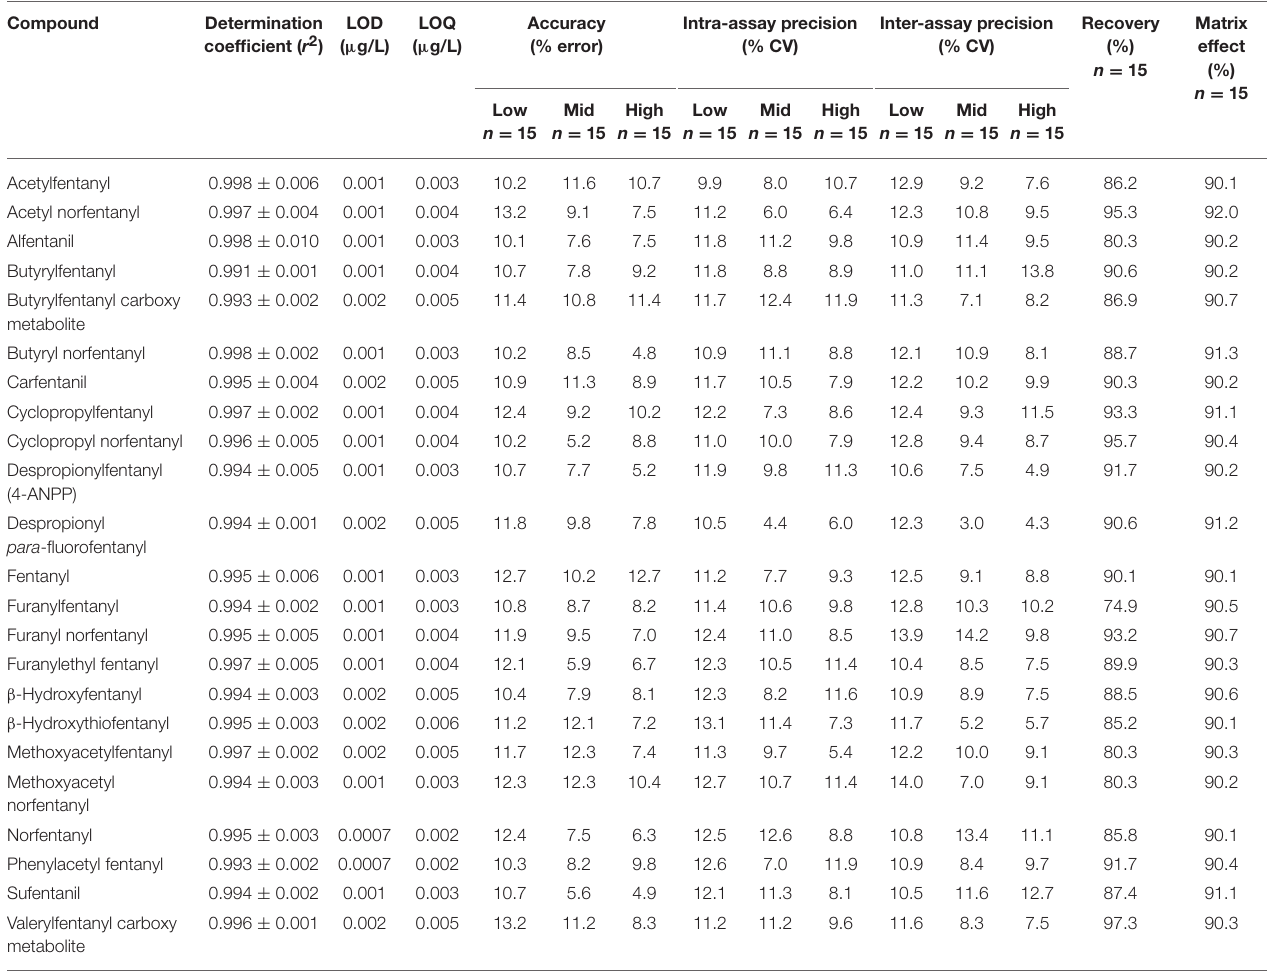
TABLE 3 | Validation parameters for fentanyl and analogs in urine.